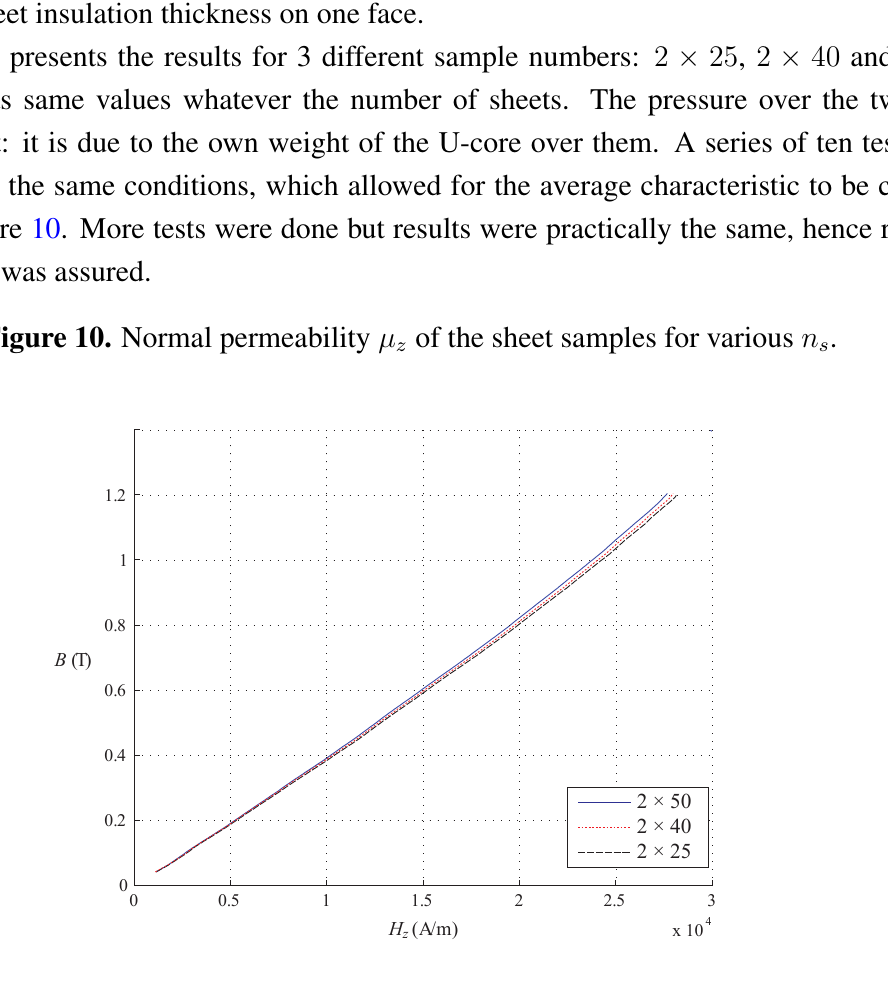
Figure 10. Normal permeability µ